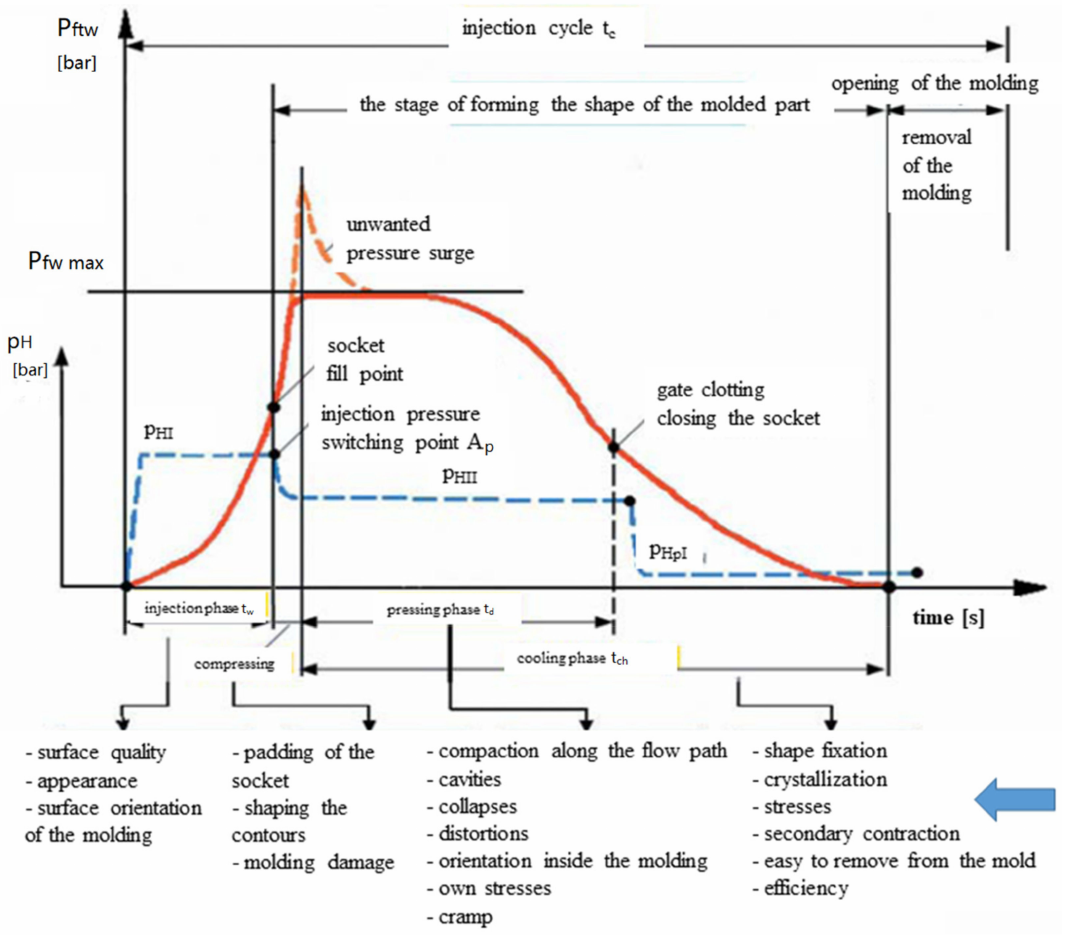
Figure 1. The course of pressure changes in the mold during the injection cycle. In the mold, during rapid flow, the pressure of the material changes depending on the flow resistance and is relatively low. However, immediately after filling the cavity, it directly increases. This growth compresses the material and is necessary for the complete filling of the cavity. On the other hand, too low injection pressure may cause shortcomings or temporary stoppages (supercooling) of the material in individual parts of the seats. The surge in pressure increase can cause stresses of the molding, dimensional disper- sion, reverse movement of the material to the cylinder, energy losses. The only way to prevent an excessive pressure surge is to switch the pressure in the (pHI) hydraulic system to a lower pressure (pHII) at the time of compression. The switching point is the switching point